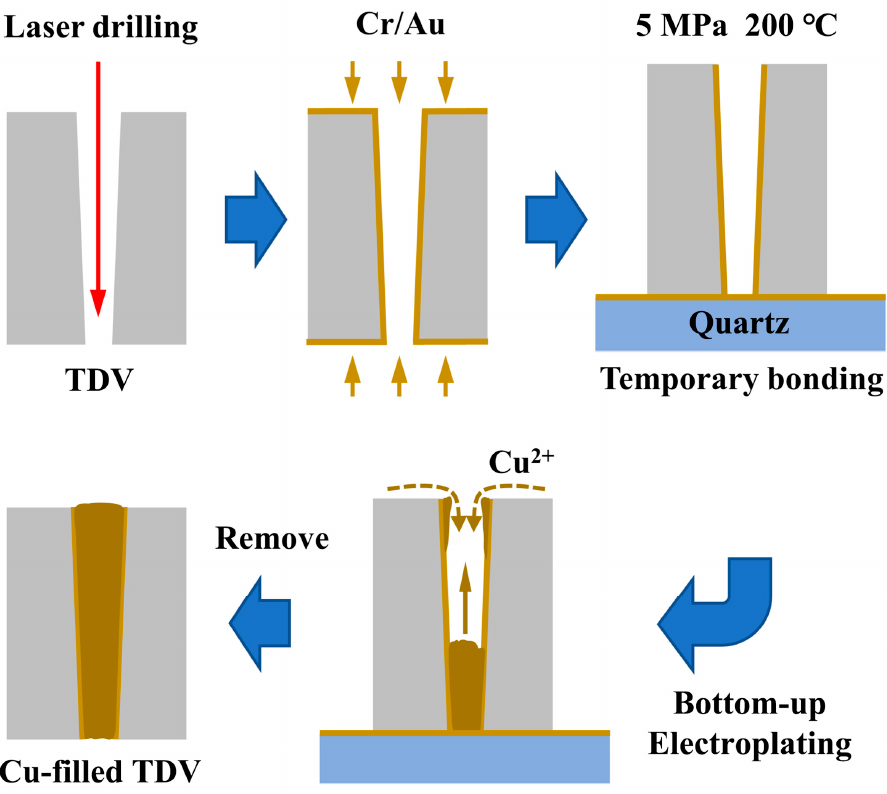
Figure 1. Schematic of the fabrication process of the Cu ‐ filled TDV.